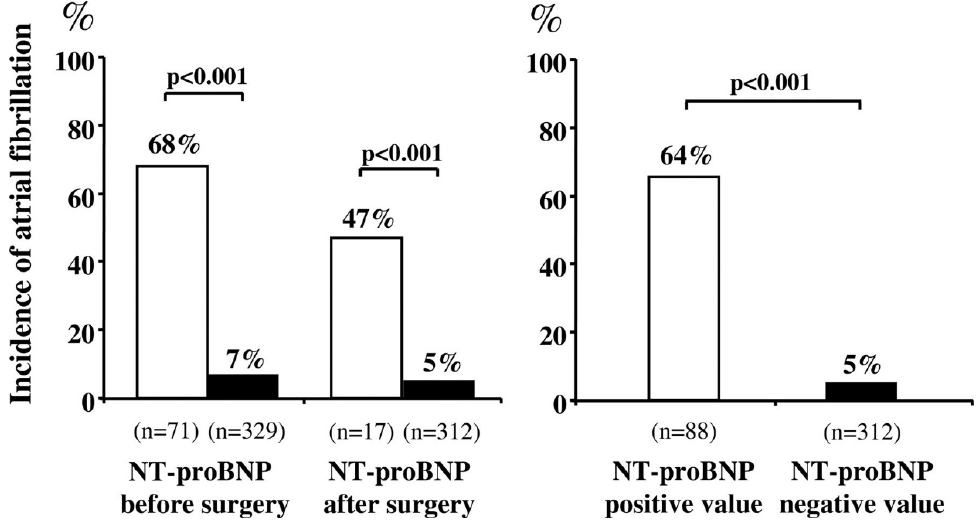
Figure 2. Left: POAF incidence in patients with high (open bar) versus normal (solid bar) preoperative and postoperative NT-proBNP values. Right: POAF incidence in patients with high (open bar) versus normal (solid bar) preoperative or postoperative (pooled) NT-proBNP values [23].